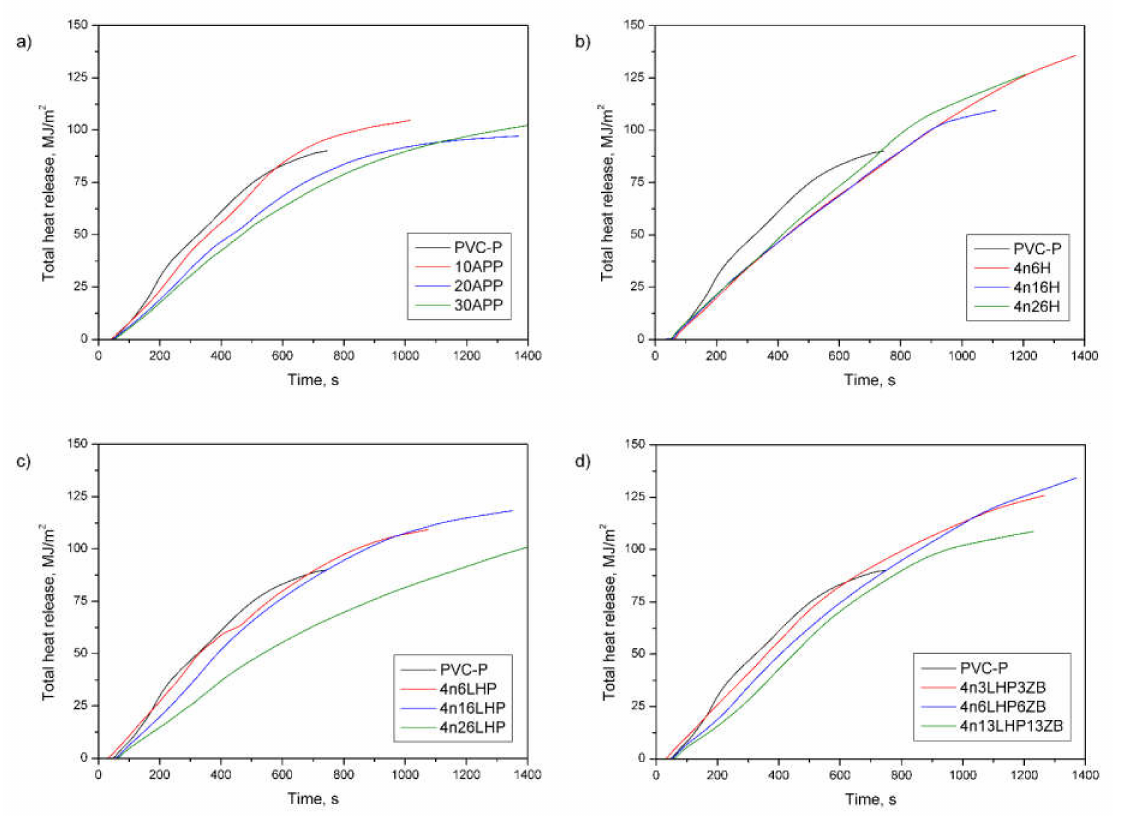
Figure 8. Representative curves of total heat release of the PVC-P and PVC-P with APP ( a ) or n/H ( b ), n/LHP ( c ), or n/LHP/ZB ( d )